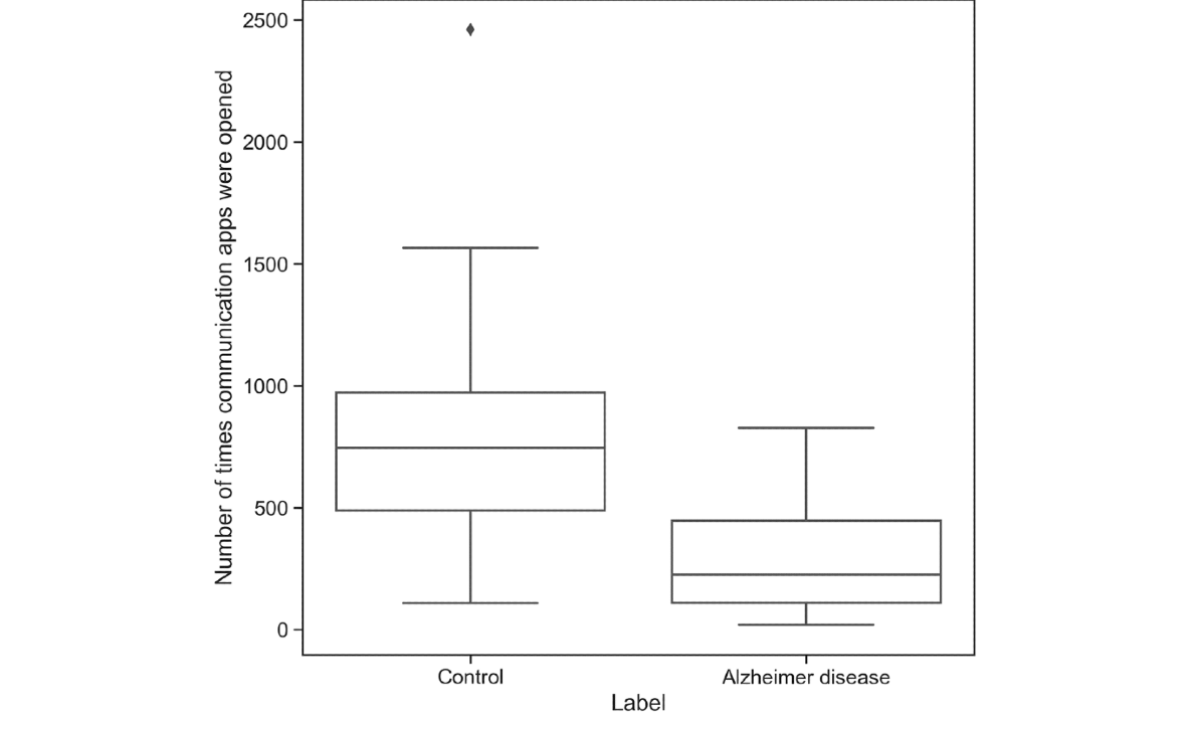
Figure 2. A group comparison data example on communication app use between Alzheimer disease patients and age-matched healthy controls (n=30) demonstrating the ability to observe differences in behavior through the use of BEHAPP’s behavioral monitoring platform. We measured a statistically significant difference in the number of times that communication apps were opened (median 746.5 and 226.0 times communication apps were opened; P =.003). The median age was 66.5 years (60% male and 40%